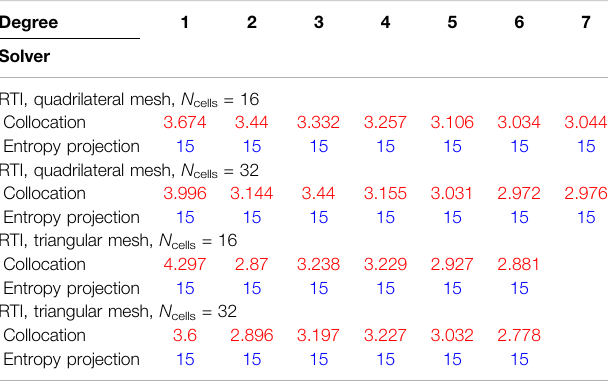
TABLE 4 | End time for simulations of the Richtmeyer-Meshkov instability on quadrilateral and triangular meshes. On quadrilateral meshes, “ collocation ” refers to a nodal DGSEM discretization, while “ entropy projection ” refers to a method based on Gauss nodes. On triangular meshes, “ collocation ” refers to nodal SBP discretization, while “ entropy projection ” refers to a modal entropy stable DG